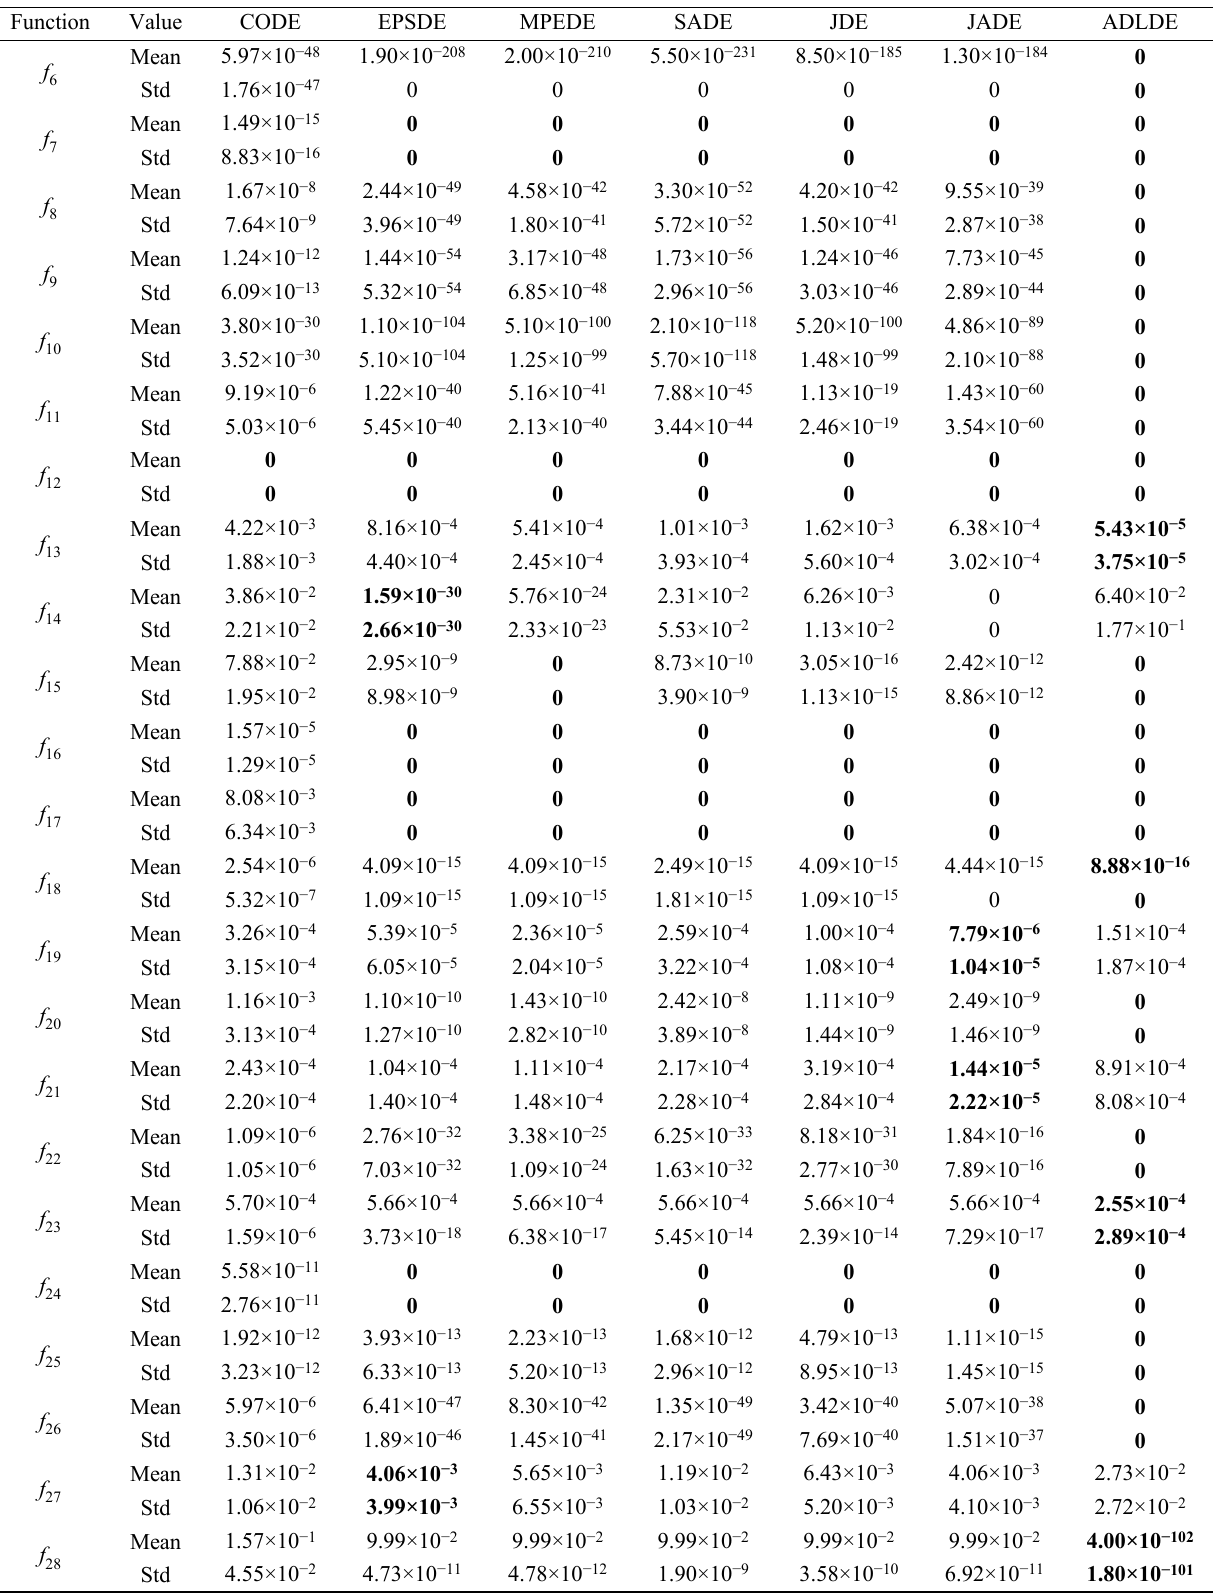
Table A2 Function error values of benchmark functions when D =